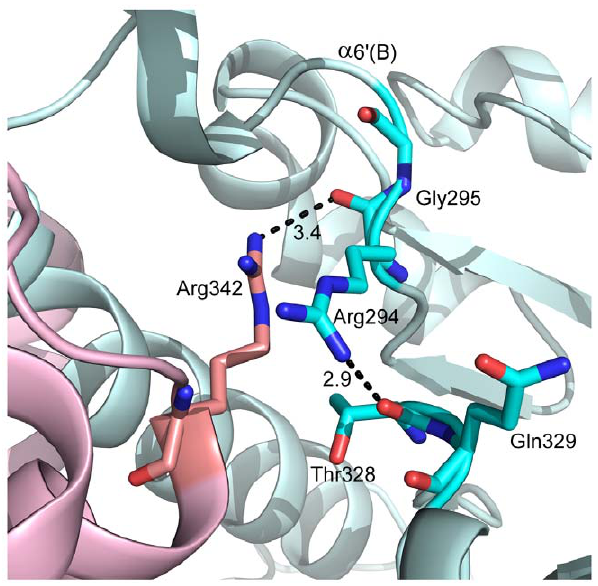
Figure 5. Cartoon drawing of monomers A (light pink) and B (light cyan) showing the orientation of the Arg342 side chain from monomer. A. Unwinding of the a 6’ helix of monomer B results in the movement of the main chain carbonyl group of Gly295 too far away for interaction with Arg342 of monomer A. Arg294, Thr328 and Gln329 of the B monomer are also shown.